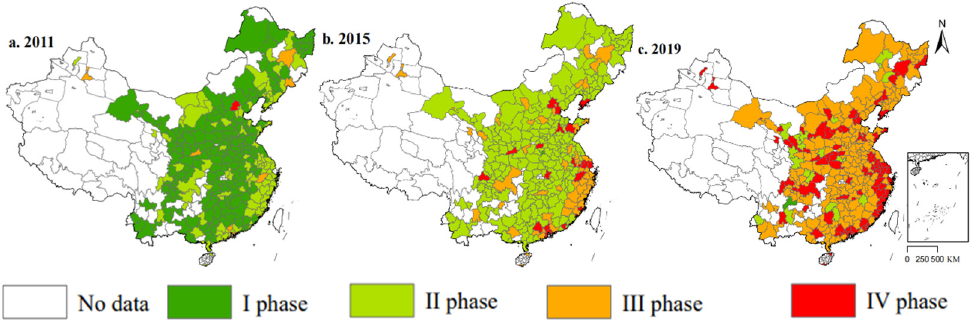
Figure 1. Spatial-temporal evolution pattern of China’s digital economy. Note : Drawn by authors using ArcGIS 10.6.